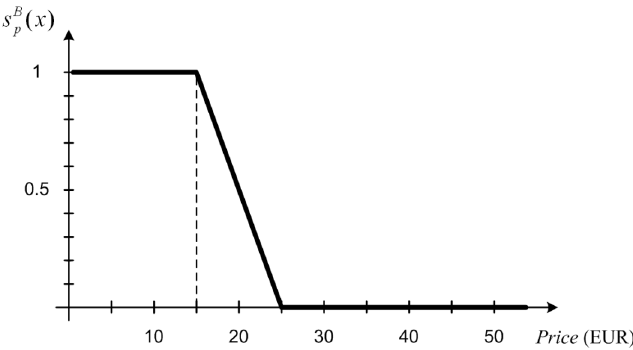
Figure 2. The Buyer’s membership function for